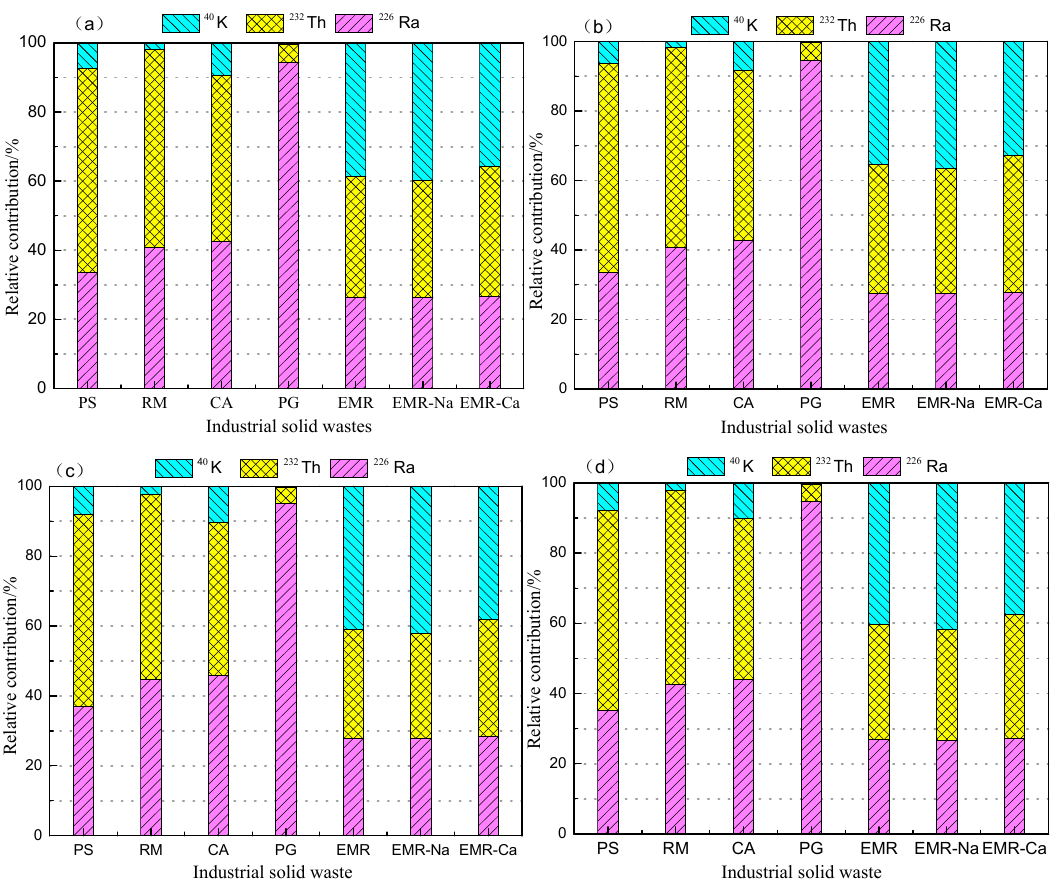
Figure 2. The relative concentrations of 226 Ra, 232 Th, and 40 K in ( a ) I γ , ( b ) Ra eq , ( c ) D in and E in , ( d ) D out and E out in industrial solid wastes. and E out in industrial solid